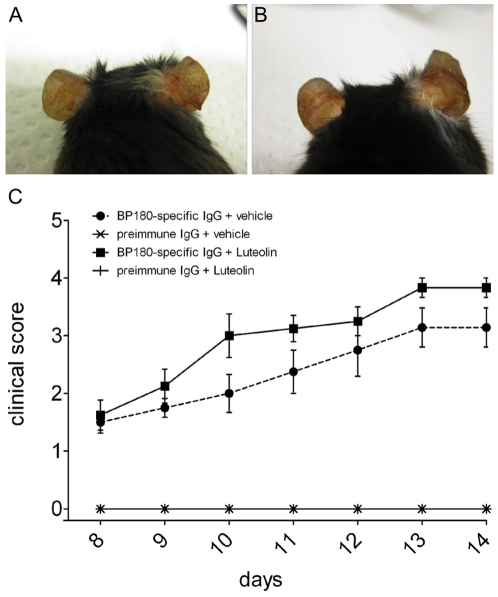

In vivo luteolin treatment does not significantly inhibit blistering in adult mice.BALB/c mice were pre-immunized with rabbit IgG and injected s.c. with BP180/CXVII-specific IgG. Control mice were pre-sensitized with rabbit IgG and challenged with the same dose of normal rabbit IgG showed no skin alterations. Topical treatment of mice with (A) luteolin at concentrations of 5.24 µM/ear did not result in different outcome compared with (B) animals treated topically with vehicle alone. (C) Treatment of mice with 1 mg luteolin i.p. daily (n = 8) did not significantly influence disease activity when compared to mice treated with vehicle alone (n = 8, p>0.5). Data are shown as mean ± SEM.